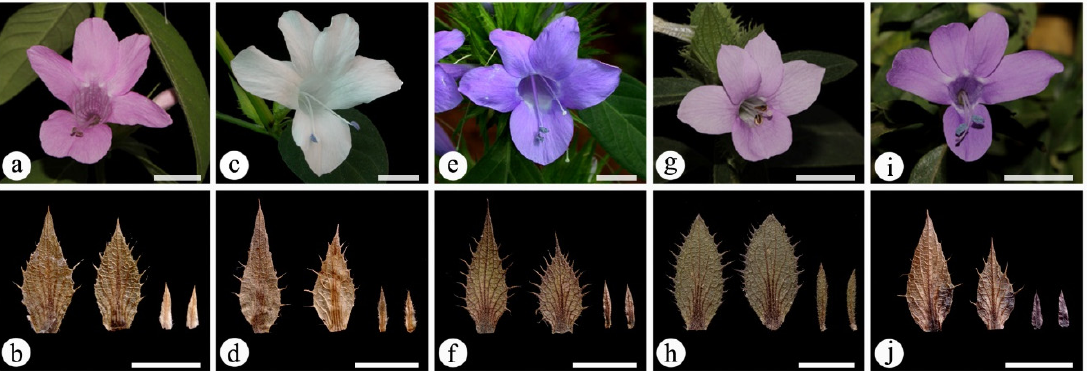
Figure 2. Barleria cristata morphotypes; ( a , c , e , g , i ) corolla lobes, front view; ( b , d , f , h , j ) two larger outer calyx lobes (adaxial and abaxial), two smaller inner calyx lobes. ( a,b ) B. cristata (cultivated form 1); ( c,d ) B. cristata (cultivated form 2); ( e , f ) B. cristata (cultivated form 3); ( g , h ) B. cristata (Nandi Hills); ( i , j ) B. cristata (Uttarakhand). Scale bars = 1 cm. Table 2. Comparative morphology of Barleria cristata morphotypes. Variable characters indicated in bold.